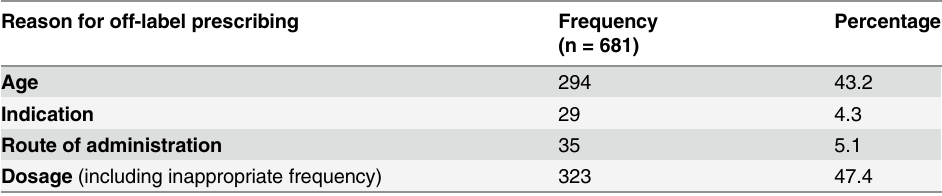
Table 6. Reasons for off-label prescribing applying the hierarchical classi fi cation